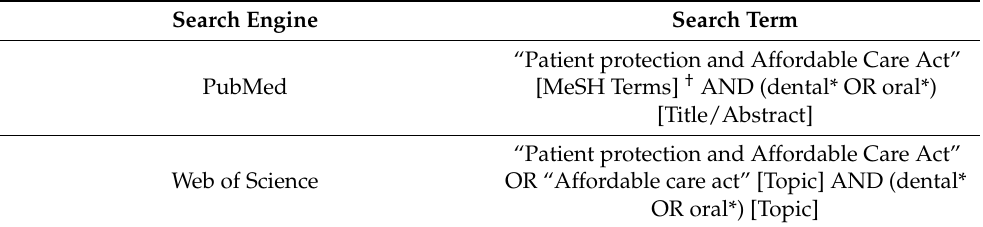
Table 1. Search terms for literature